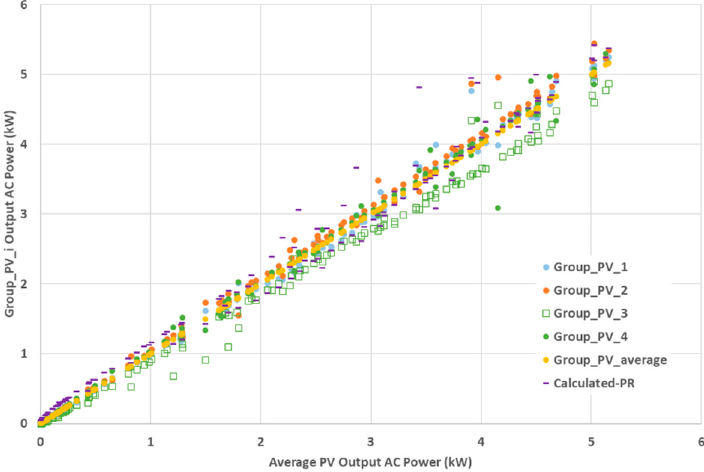
Figure 9. Cross-correlation between the power output of a group of modules (one inverter per string) and the average value of several groups. The four groups are technically identical (same nominal power installed, location and tilt) and are operating in the same conditions (real time). The cross-correlation can easily identify a faulty string (in green squares).